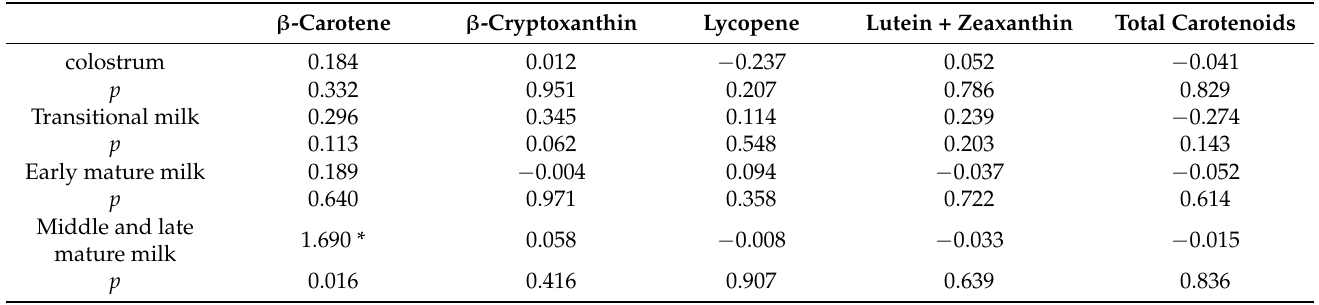
Table 8. Association between dietary intake and the content of carotenoid in breast milk at postpartum 0–400